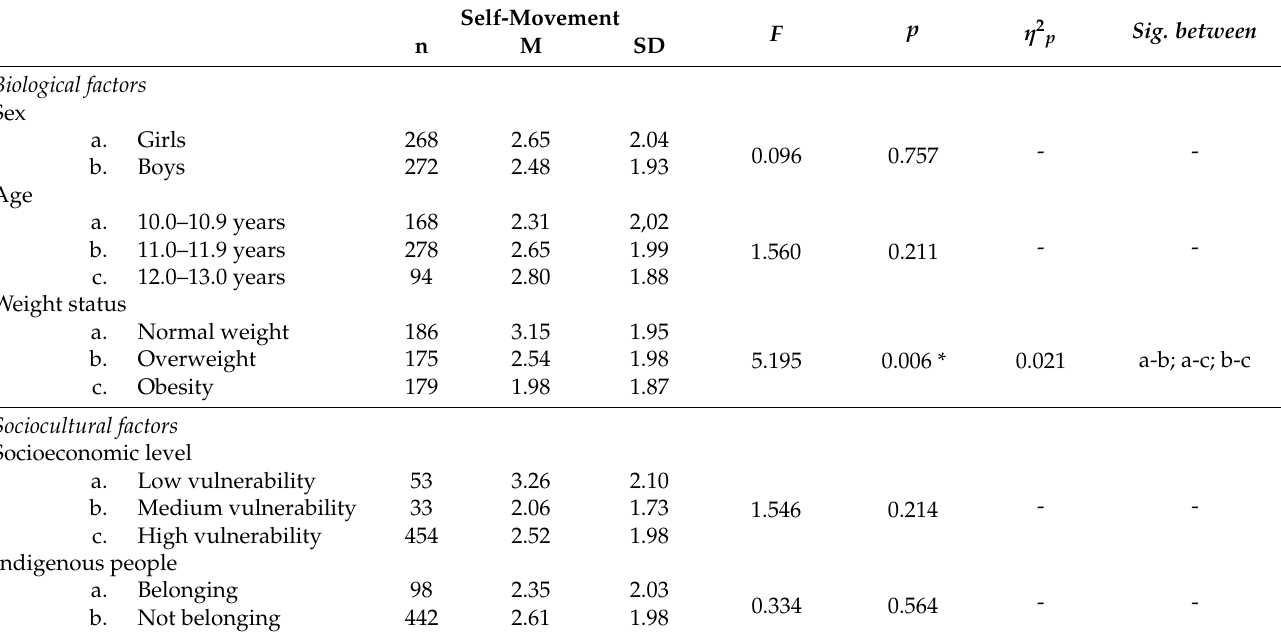
Table 3. Results for the self-movement domain according to sex, age, weight status, socioeconomic level and belonging or not belonging to an indigenous people. Self-Movement F p η 2 p Sig. between n M